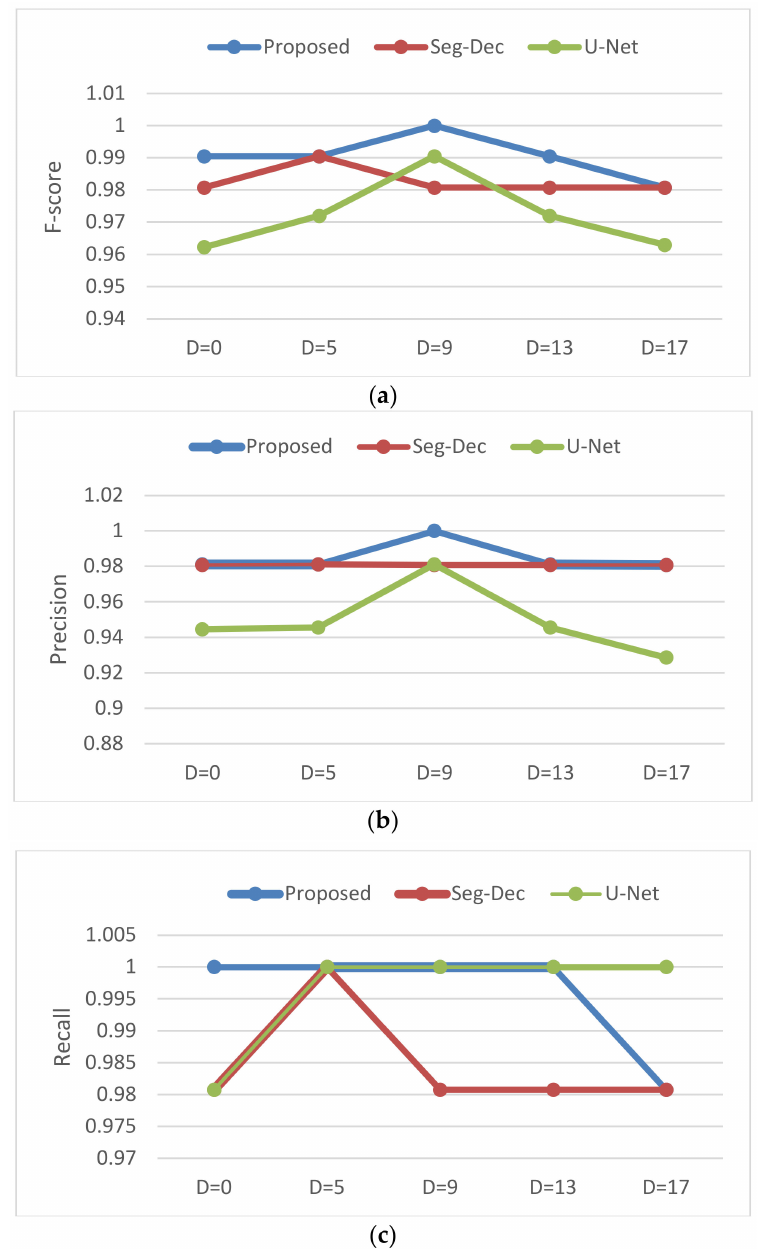
Figure 9. Performance comparisons with di ff erent dilate rate. ( a ) f-score; ( b ) precision; ( c )